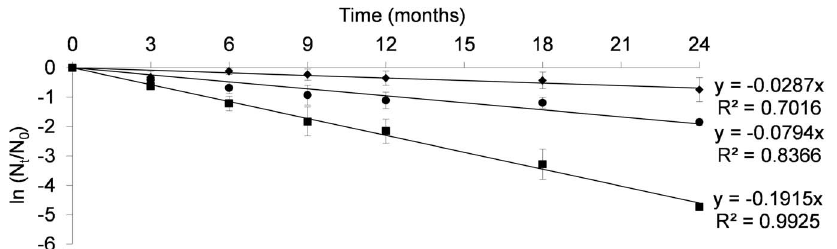
N ) and 30 u C ( & ) (Mean of eleven values), according to the current